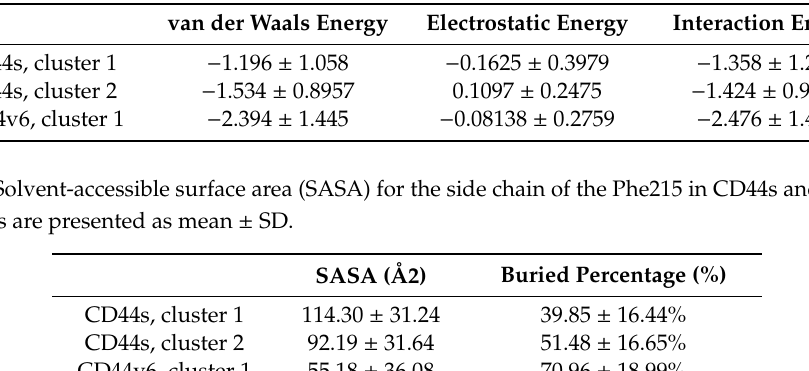
Table 1. Interaction energy (kcal / mol) between the side chain of Phe215 and the residues that were involved in the persistent hydrophobic contacts listed in Table S4. All of the values are presented as mean ± SD.